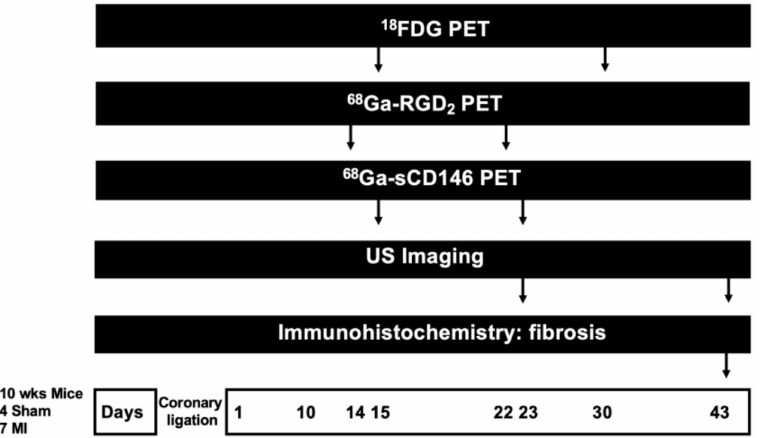
Figure 1. Experimental